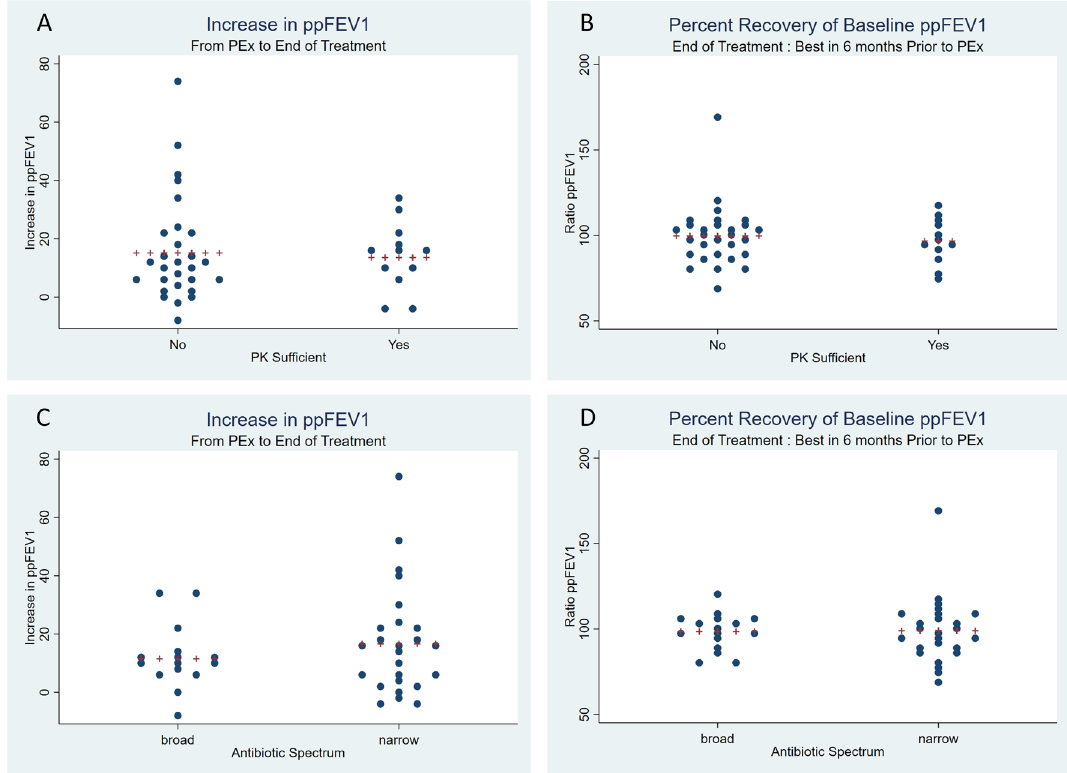
Figure 4. Recovery of pulmonary function. Panel ( A ) Increase in ppFEV1 from PEx to end of antibiotic treatment by beta-lactam pharmacokinetic exposure. Panel ( B ) Percent recovery of baseline ppFEV1 at end of treatment compared to the best ppFEV1 in the 6 months prior to PEx by beta-lactam pharmacokinetic exposure. Panel ( C ) Increase in ppFEV1 from PEx to end of antibiotic treatment by antibiotic spectrum exposure. Panel ( D ) Percent recovery of baseline ppFEV1 at end of treatment compared to the best ppFEV1 in the 6 months prior to PEx by antibiotic spectrum exposure. ppFEV1, percent predicted forced expiratory volume in one second; PEx, pulmonary exacerbation. Plus signs represent the